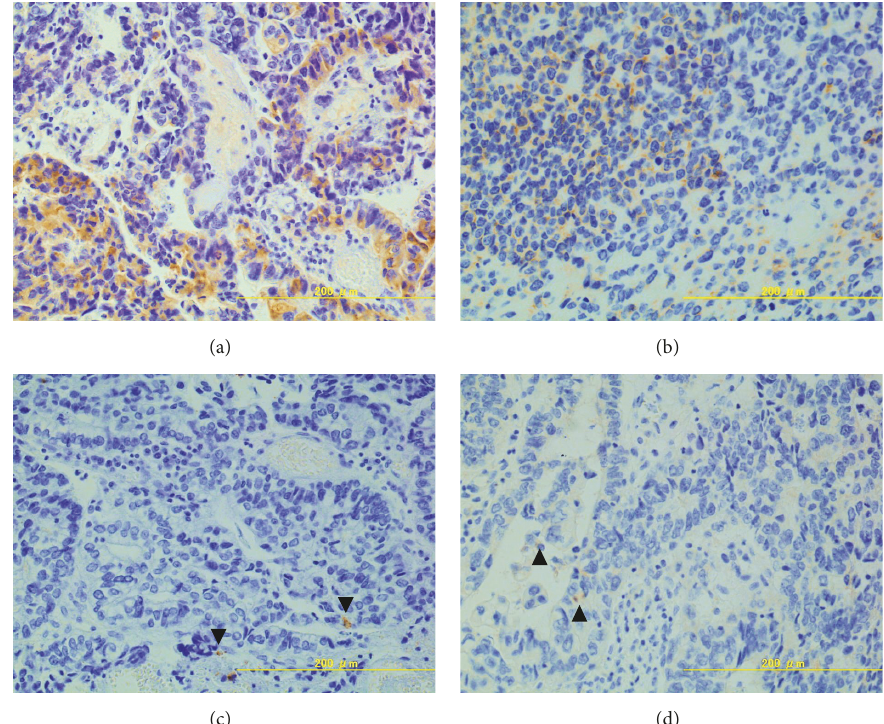
Figure 4: Immunohistochemicalfindings. (a) Tumor cells strongly positive stained for AFP ( × 200). (b) Positive staining for CD56 ( × 200). (c, d)Severalcellswereimmunohistochemicallypositive for (c)chromograninA( × 200,arrowheads)and (d)synaptophysin ( ×